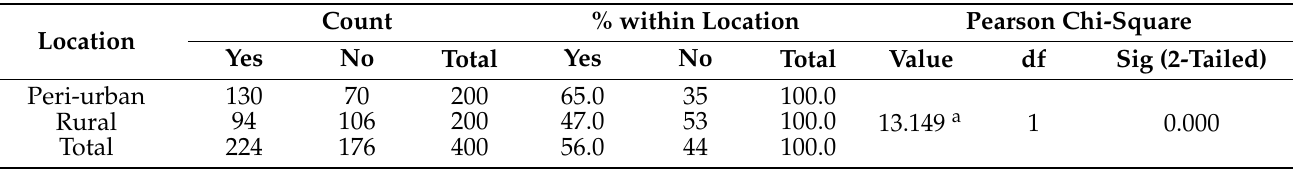
Table 2. Extent of land tenure